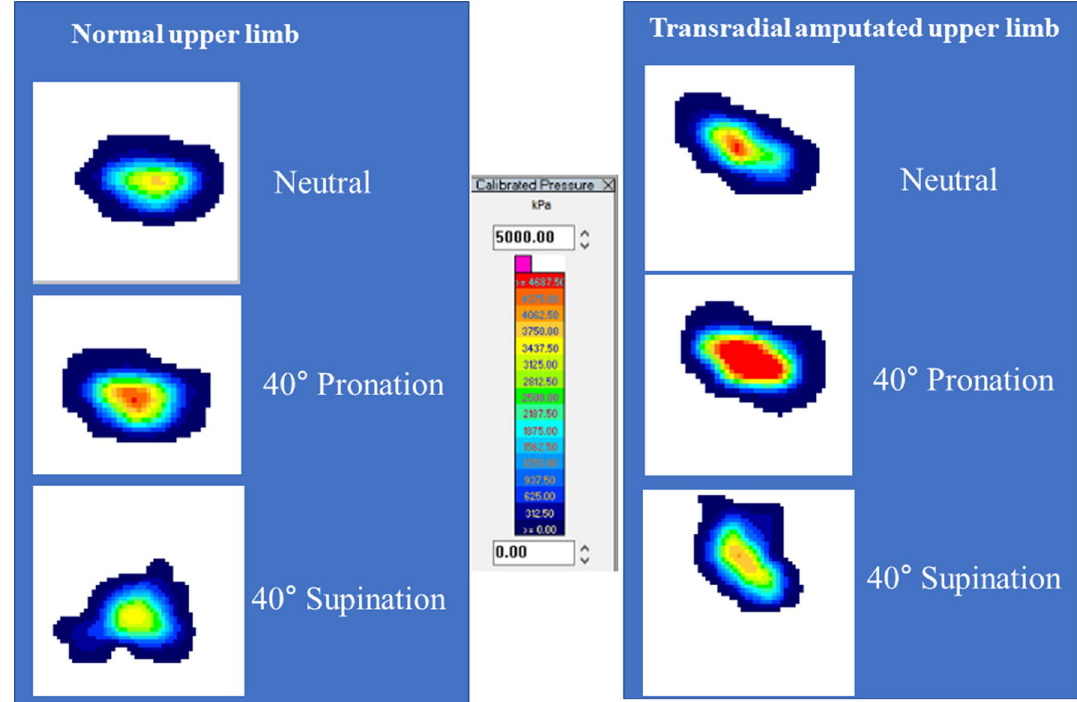
Figure 4. These colour maps show pressures at an elbow flexion angle of 45° in normal and transradial amputated upper limbs. Pressures were increased in the upper limbs after transradial amputation compared to the normal upper limbs. The increased pressures in the upper limbs after transradial amputation were most evident during